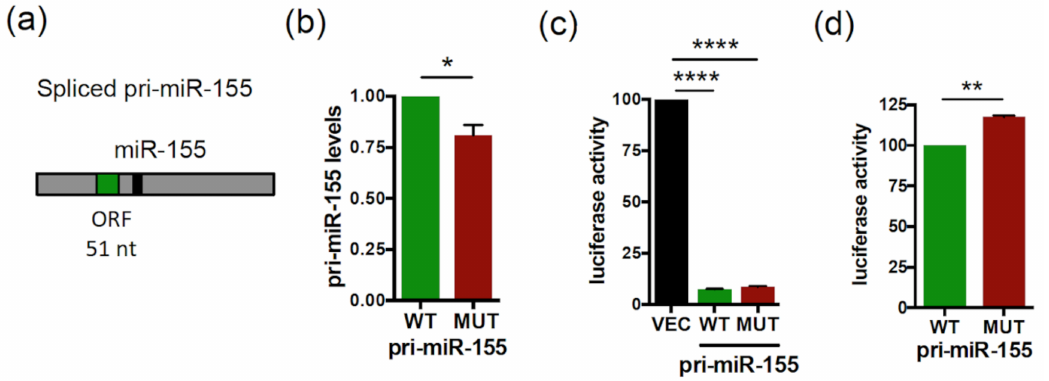
Figure 1. The smORF51 of Human pri-miR-155 regulates the expression and activity of pri-miR- 155/miR-155. ( a ) Schematic structure of Human spliced pri-miR-155 with the miR-155 (black box) and smORF51 (green box) indicated. ( b ) Relative expression levels of wild type (WT) or mutant (MUT) pri-miR-155 transfected in HeLa cells and determined by quantitative RT-PCR analyses